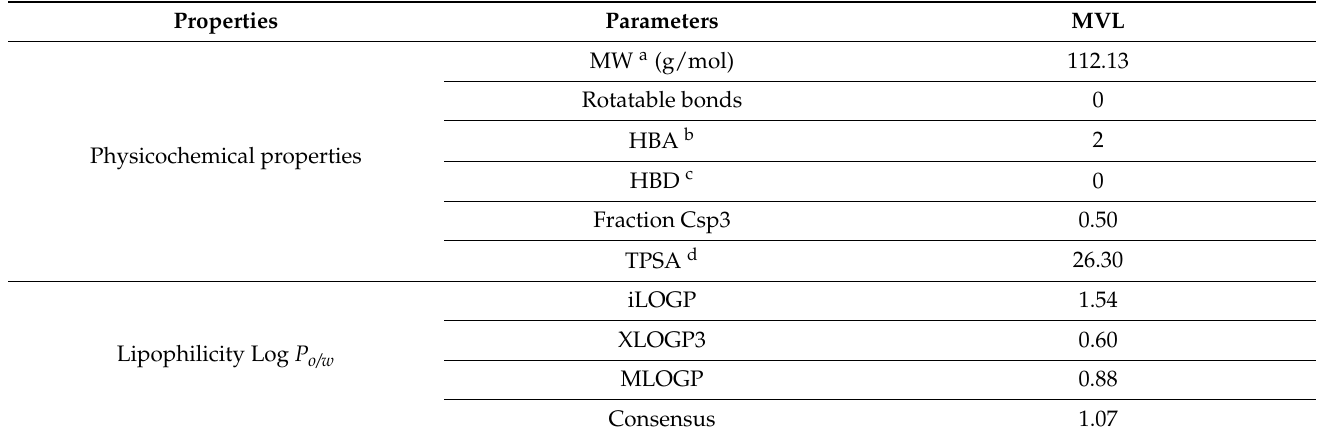
Table 4. Predicted physicochemical parameters and lipophilicity properties of MVL.